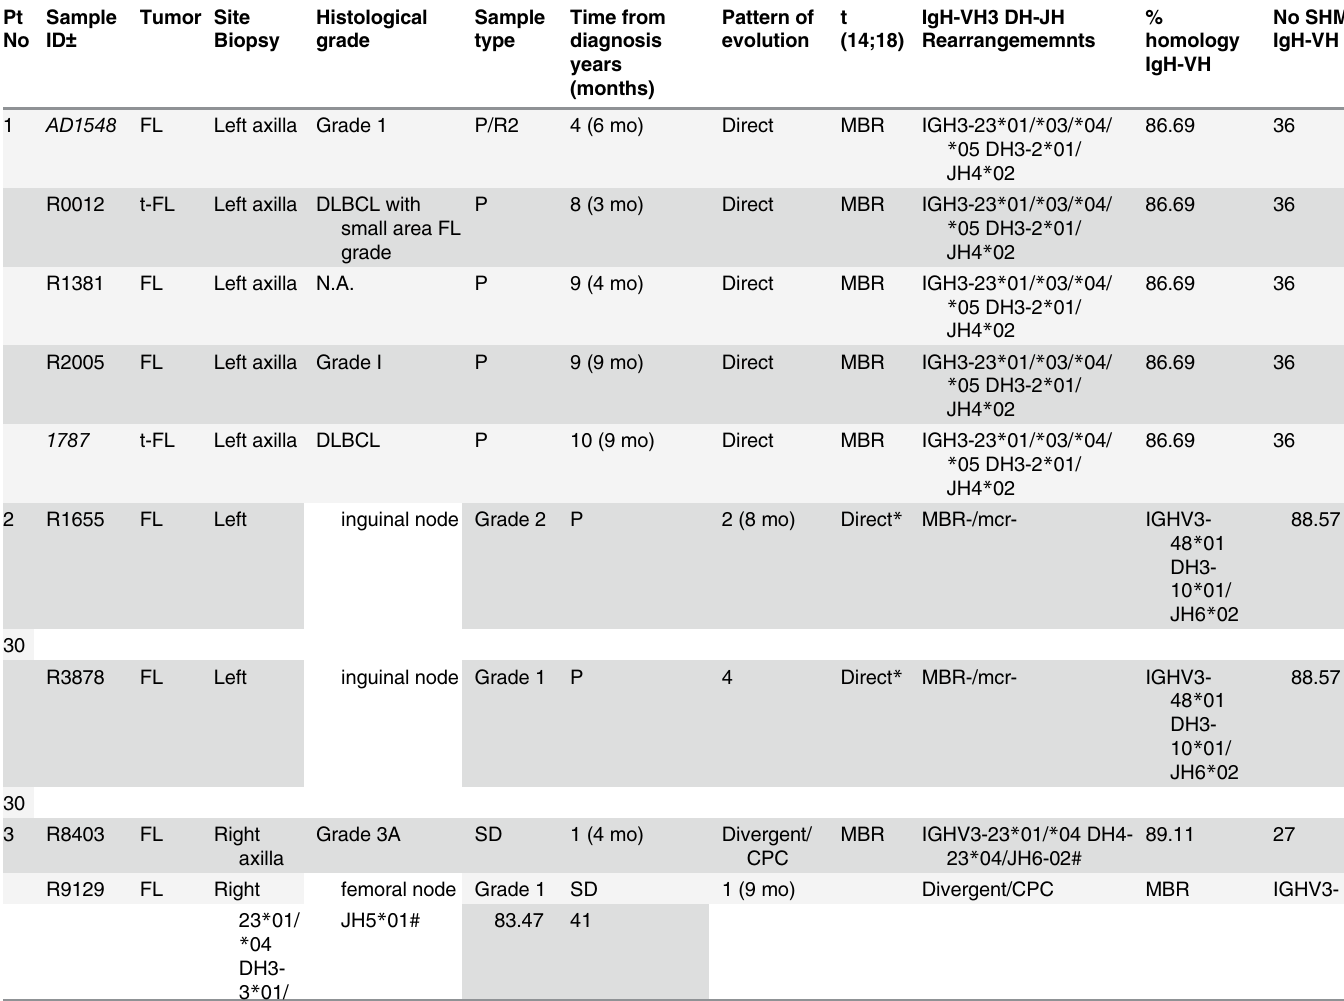
Table 1. Clinical and molecular features of the 3 patients investigated by high-throughput sequencing. Pt Sample No ID